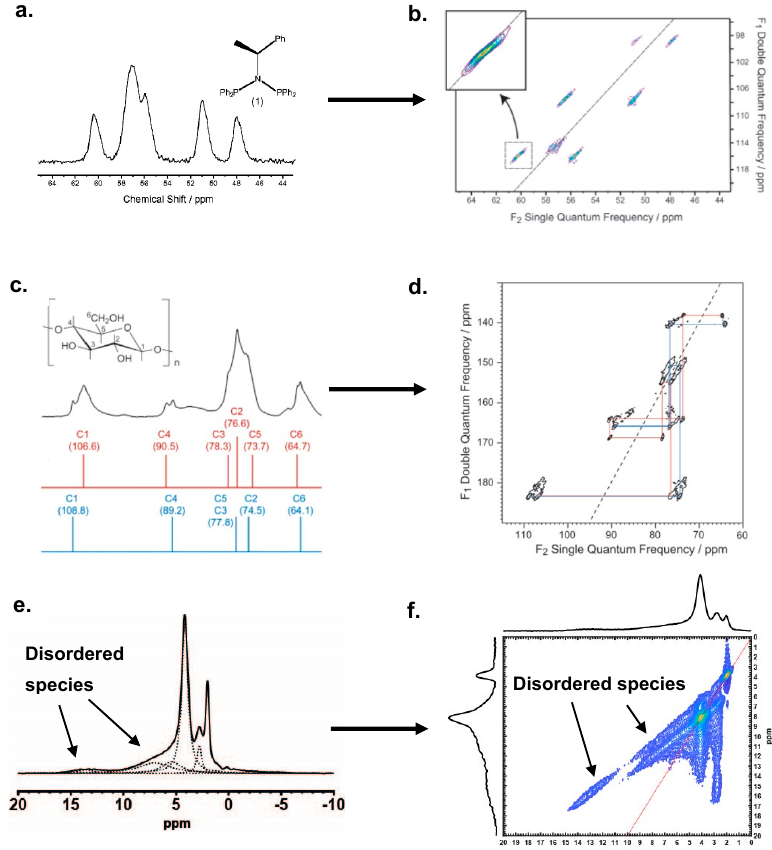
Figure 4. Typical types of disorder patterns illustrated by 1D MAS and 2D MAS DQ-SQ spectra in three materials, which are 1D ( a ) and 2D INADEQUATE ( b ) 31 P NMR for N,N-bis(diphenylphosphino)-N-((S)-R-methylbenzyl)amine ; 1D ( c ) and 2D INADEQUATE ( d ) 13 C NMR for 10% carbon-13 labeled cellulose; 1D ( e ) and 2D dipolar-based DQ-SQ ( f ) 1 H NMR for dehydrated zeolite catalyst HZSM-5. ( e ) was acquired at 9.4 T, at 10 kHz spinning frequency. ( a – d ) are reprinted (adapted) with permission from Ref. [13]. Copyright (2020) American Chemical Society. ( f ) is reprinted (adapted) with permission from Ref. [8]. Copyright (2020) American Chemical Society.